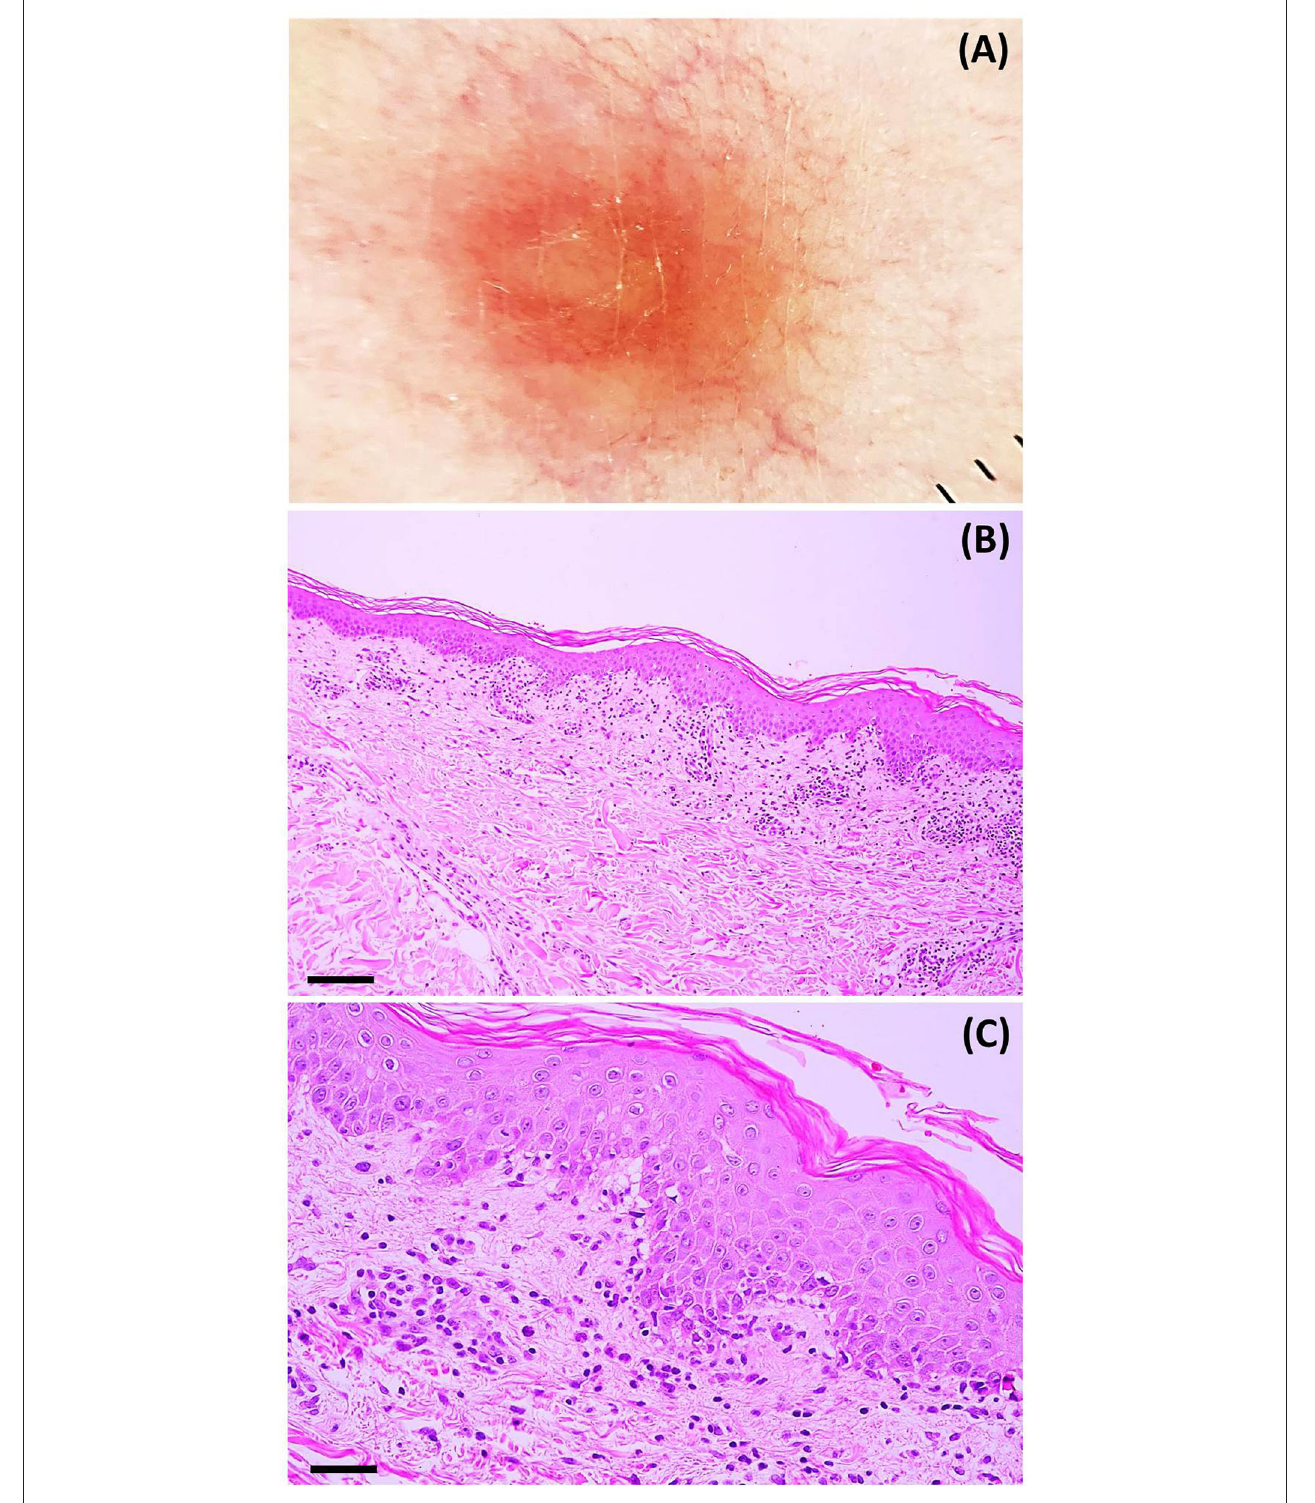
FIGURE 3 | (A) Dermoscopic features: dotted and linear vessels forming a network on a yellowish background with some whitish peripheral scales (original magnification x20). Histopathologic features: (B) microscopic image at a low power field showing psoriasiform epidermal hyperplasia, perivascular infiltration, and interface dermatitis (hematoxylin-eosin; scale bar represents 100 µ m); (C) microscopic image at a high power field showing focal spongiotic dermatitis, interface dermatitis, and perivascular infiltration of lymphocytes and eosinophils (hematoxylin-eosin; scale bar represents 40 µ m).